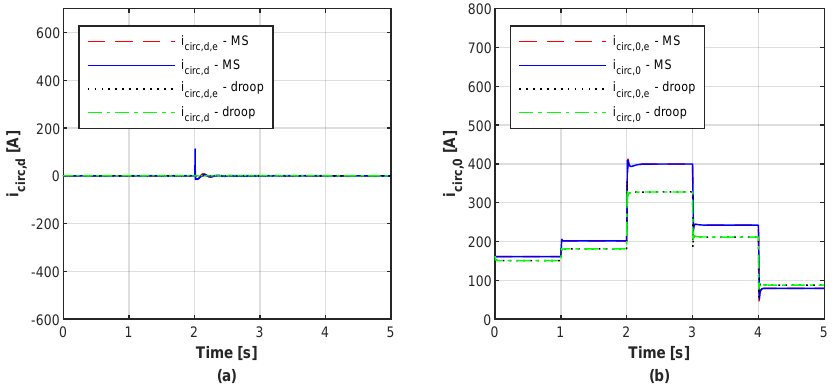
Figure 15. Circulating current response from the master terminal: ( a ) i circ , d ; ( b ) i circ ,0 .